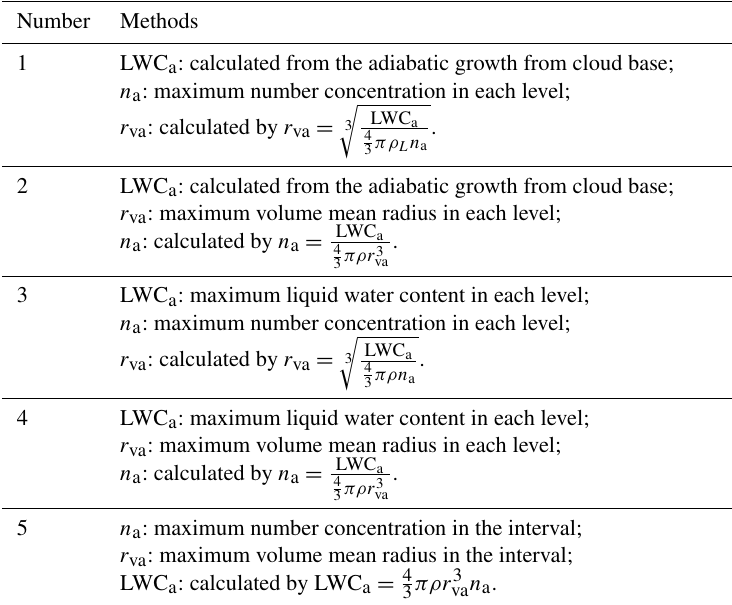
Table 1. List of different methods determining adiabatic values. Number